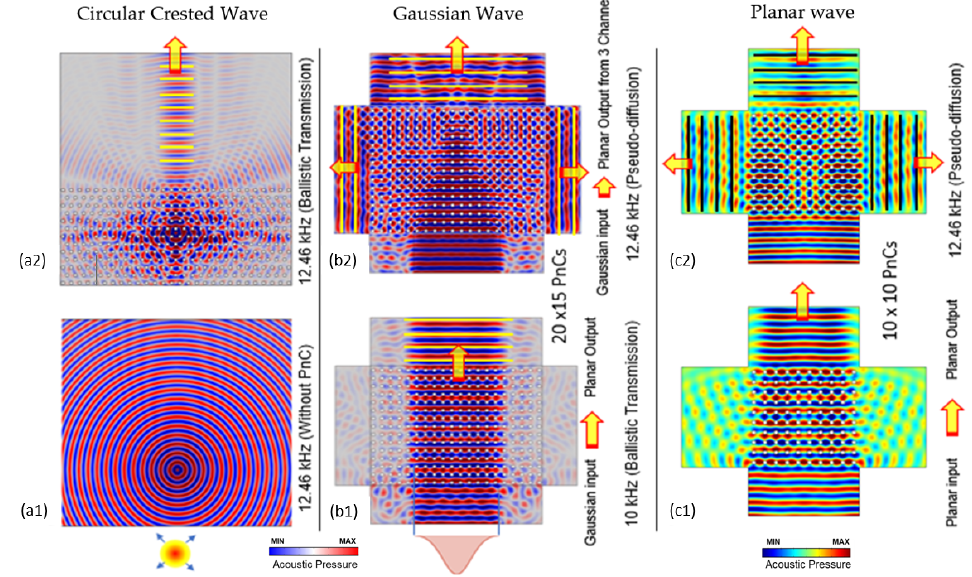
Figure 8. ( a1 ) Pressure field distribution for cylindrical wave excited by a pseudo-point source at Dirac frequency, without any PnCs ribbon, ( a2 ) a prominent ballistic transmission along Γ X when the square rod PnCs were introduced, at f = 12.458 kHz, A PnCs ribbon with a 28 × 13 matrix acting as a perfect acoustic collimator, diffuser, and a wave-front reshaping media excited around the Dirac frequency, while excited by a pseudo-point source inside the PnCs, ( b1 ) Pressure field distribution when a Gaussian beam is incident on PnCs slab at f = 11 kHz, depicting perfect ballistic transmission, ( b2 ) A Gaussian wave source is excited at the Dirac frequency. Wave diffusion due to orthogonal transport is eminent and wave-front transformation from Gaussian beam to plane wave- front is observed at f = 12.458 kHz ( c1 ) A planar wave source is excited at frequencies below the Dirac frequency, output wave transmission is planar wave, ( c2 ) A planar wave source is excited at the Dirac frequency. Wave diffusion due to orthogonal transport is eminent.